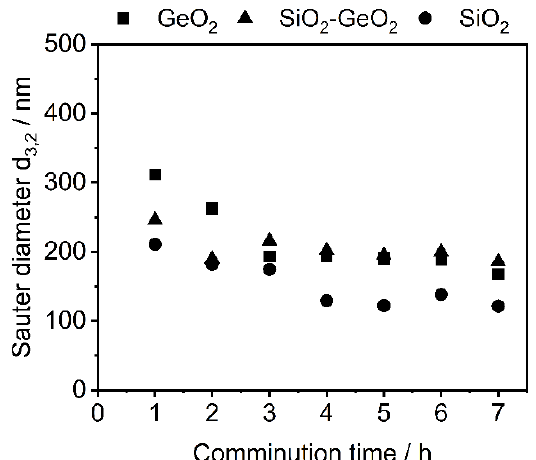
Table 6. Main IR absorption bands for SiO 2 ‐ and GeO 2 ‐ based glasses.